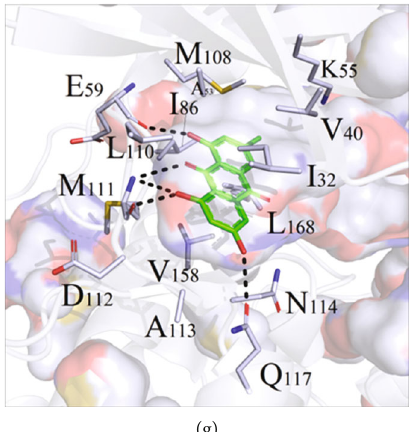
Figure 4: Identi fi cation of Emodin-binding proteins. (a) Chemical structure of emodin and bio-emodin ( fl uorescent tag). (b) A schematic chart of identi fi cation of bio-emodin-binding protein using a proteome microarray. (c) Images of location of JNK2 in the biotin control and the bio-emodin microarray and details of the bonding. (d) Pulldown detection for the interaction of emodin and JNK2 in MODE-K cells. M: marker; L: loading bu ff er. (e) E ff ect of emodin on JNK2 phosphorylation. Western blot was employed to detect p-JNK2 expression, and three independent experiments were performed. (f) Emodin and JNK2 are shown as cartoon and sticks, respectively. It is color coded according to the electrostatic potential. Blue: hydrophilic amino acid; white: neutral amino acid; and orange: hydrophobic amino acid. (g) Electrostatic interaction pattern diagram of pockets around small molecules. Details of interaction is shown color-coded according to the electrostatic e ff ects of emodin on intestinal structure should be consid- ered as a promising preparation in the prognosis of sepsis.